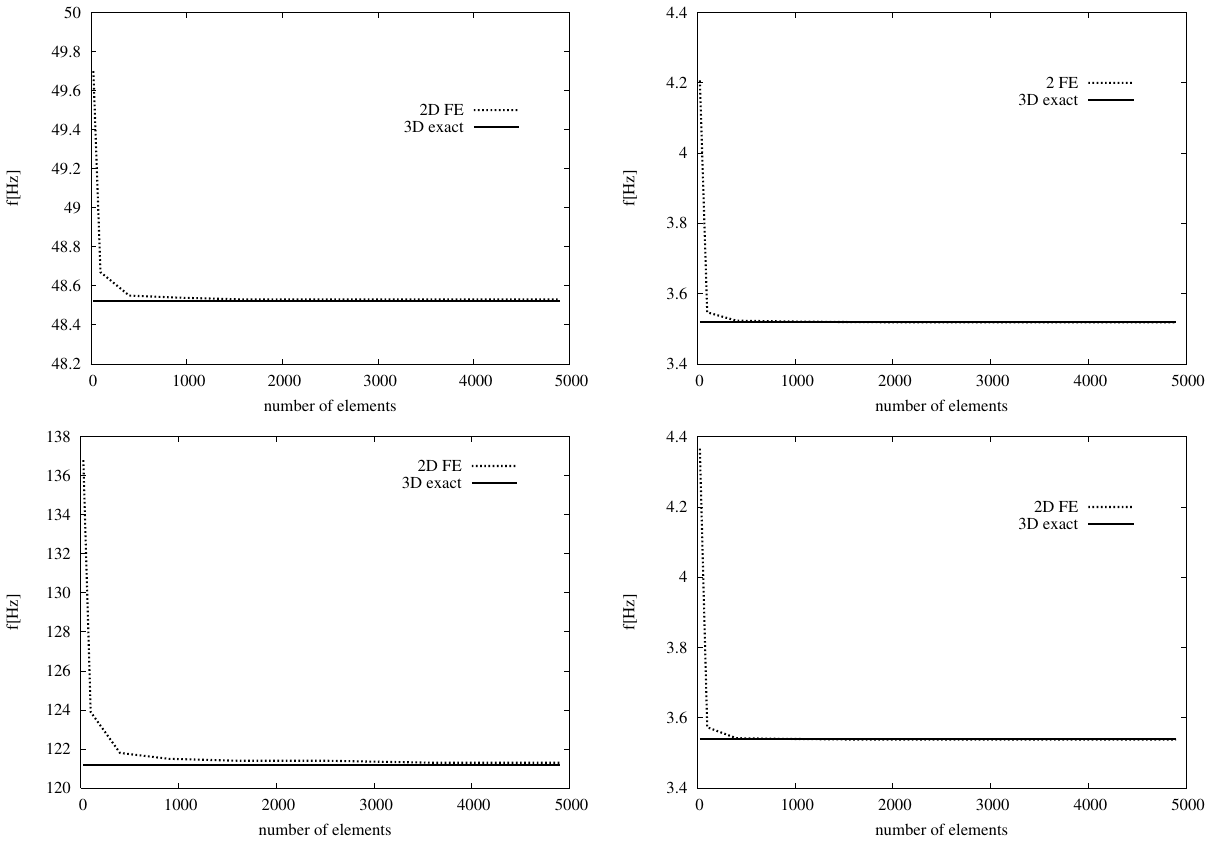
Figure 5: First assessment for the 2D FE solution, simply supported plate made of aluminium alloy with thickness ratio a/h=100. Fre- quency f[Hz] vs. number of elements for the mode (1,1) (at the top) and for the mode (1,2) (at the bottom).